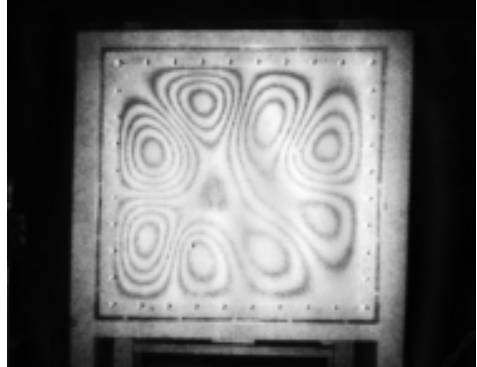
Fig.2. Imageoftheinterferencepatternscorrespondingtoonedouble exposure at t A and t B shown in Fig. 1. The vibrating velocity in the plate at an instant is obtained by processing this image.